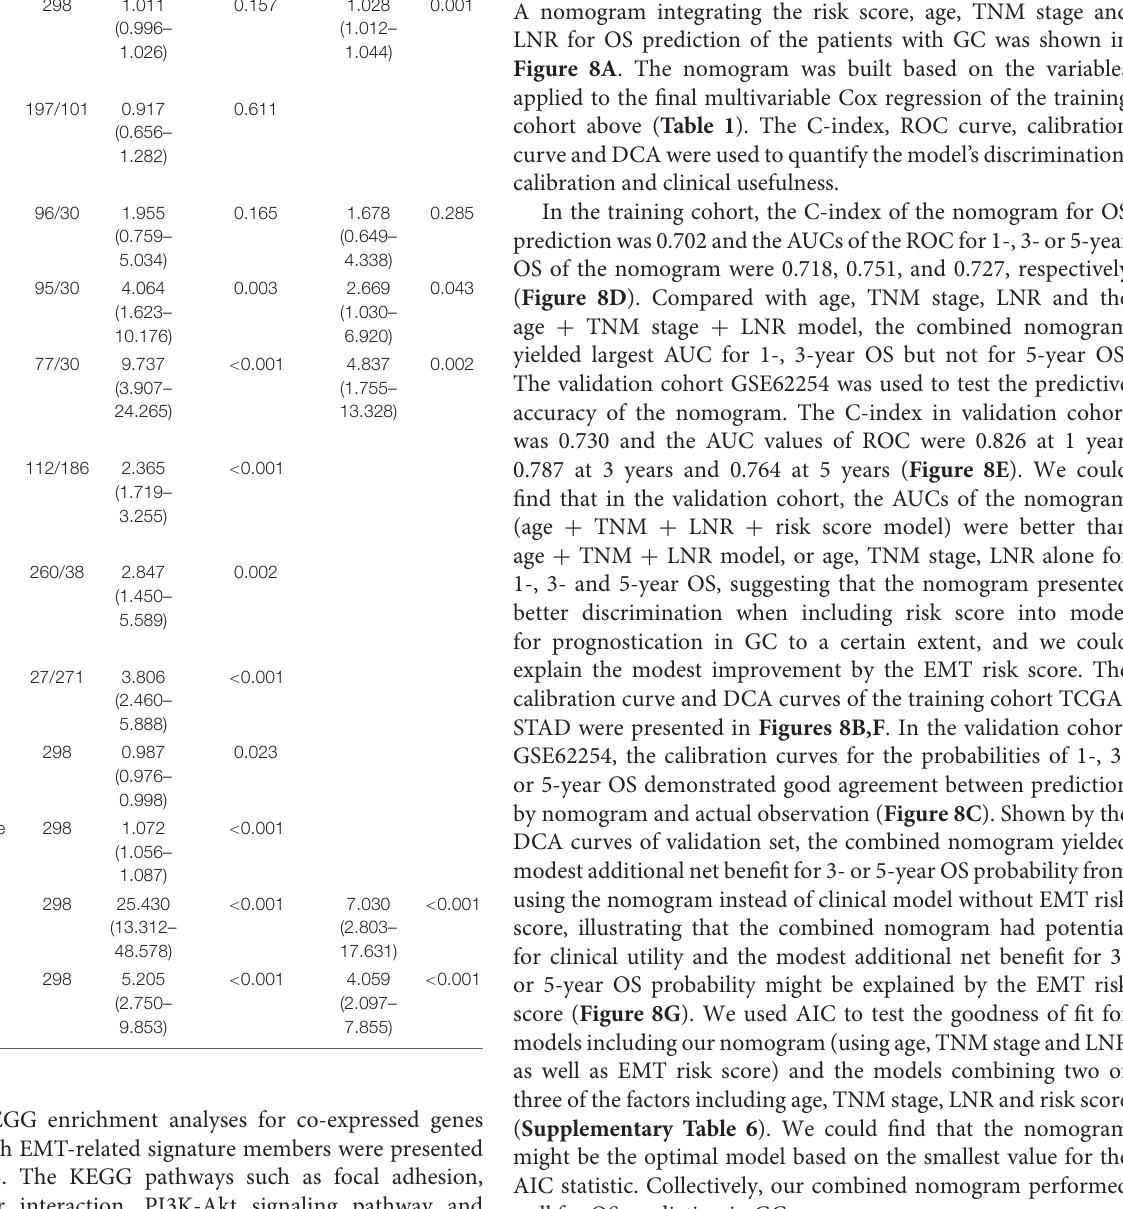
Figure 8A . The nomogram was built based on the variables applied to the final multivariable Cox regression of the training cohort above ( Table 1 ). The C-index, ROC curve, calibration curve and DCA were used to quantify the model’s discrimination, calibration and clinical